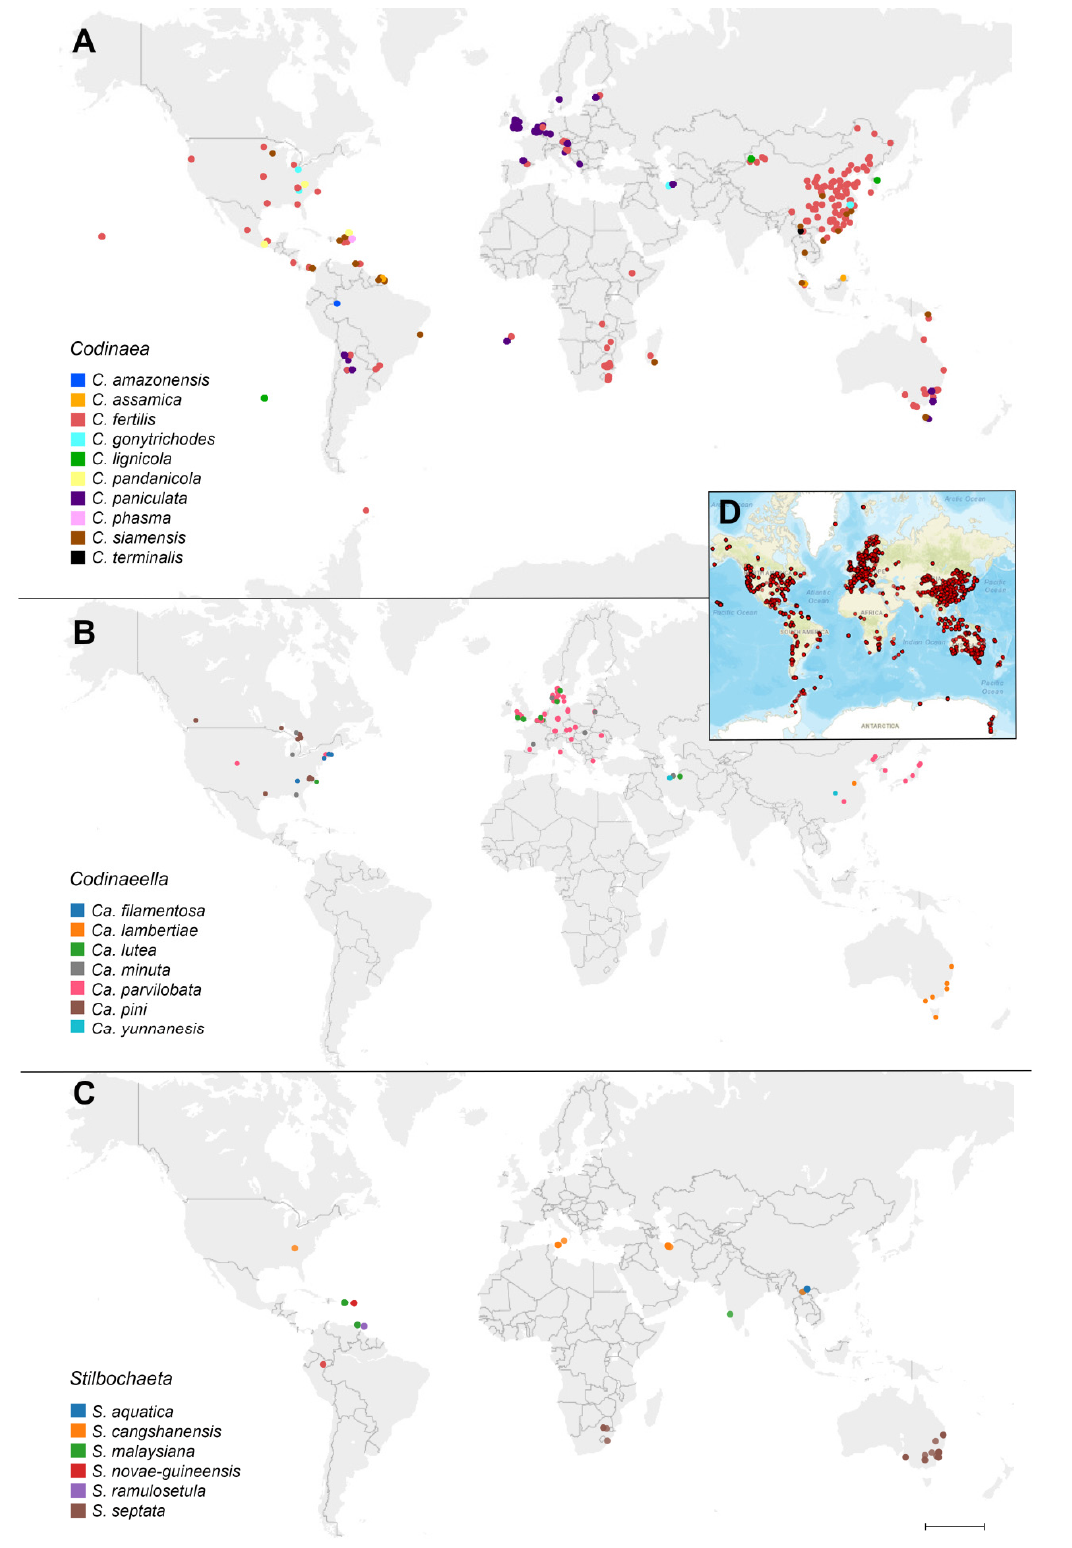
Figure 7. Geographical distribution of ( A ) Codinaea , ( B ) Codinaeella, and ( C ) Stilbochaeta species based on the GlobalFungi database. See Table S2 for primary data. Species are differentiated by colors. ( D ) The circles represent smaller geographical areas with one or more observations of the particular species. Some of the smaller areas contained observations of multiple species (e.g., Caspian coast, Puerto Rico); circles were manually dispersed over the actual collection site. Scale bar: 2000